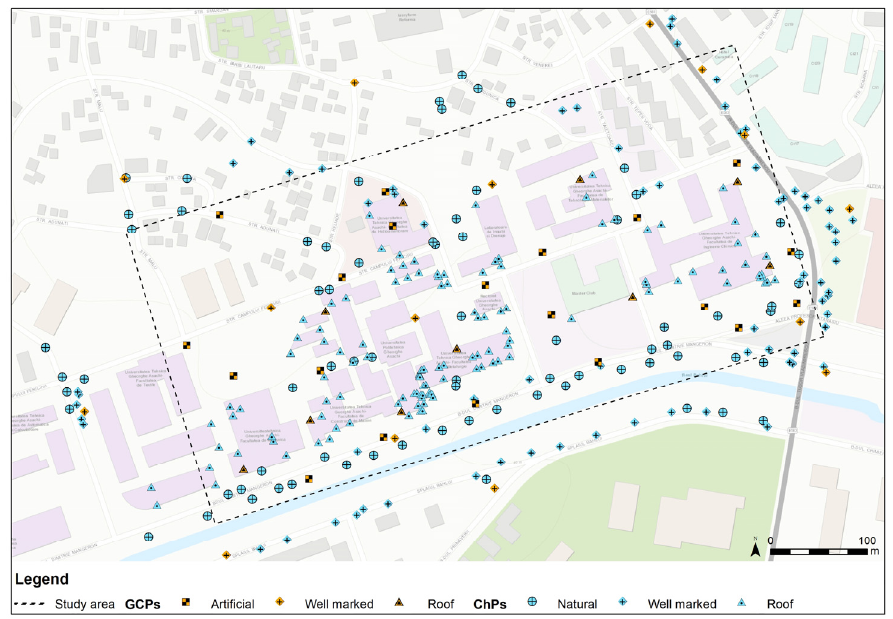
Figure 5. The spatial distribution of the 320 ground control points (GCPs) and check points (ChPs).